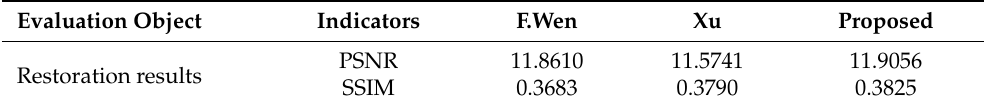
Figure 9. Result of the Kohler library. At the top, from left to right, are the results of the proposed method, Xu, and F.Wen, and the estimated kernel; below are the blurred image and details from the line above. Table 6. Restoration quality evaluation table of Kohler’s bell.